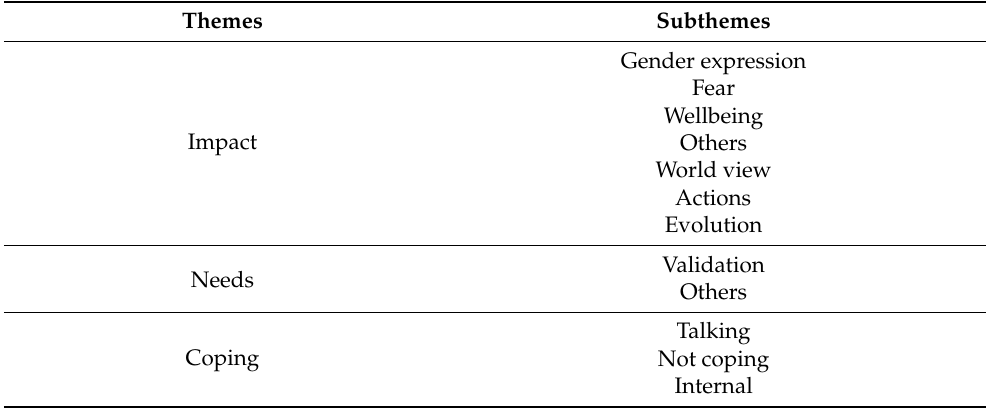
Table 2. Impact, needs, and coping: themes and